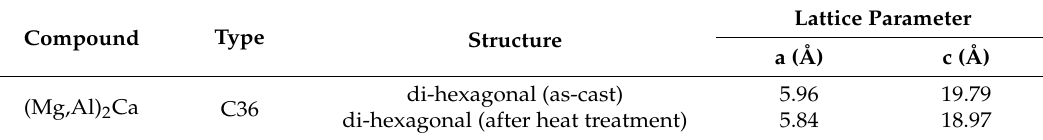
Table 4. Crystal structures and lattice parameters of (Mg,Al) 2 Ca Laves phases [16].